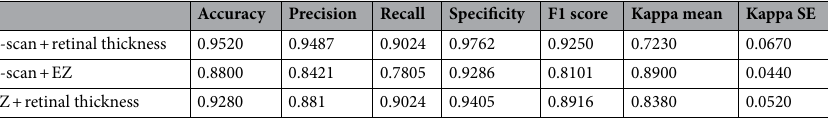
Table 3. The performance of the deep learning models trained using concatenated OCT image sets for CSC prognosis. OCT: optical coherence tomography; CSC: central serous chorioretinopathy; SE: standard error; EZ: ellipsoid zone. F1 score = 2 × {(precision × recall)/(precision +